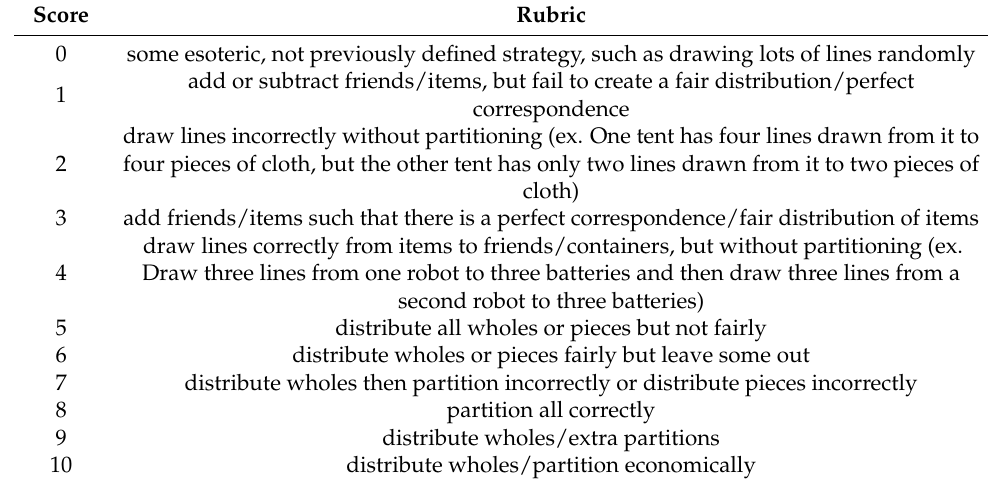
Table 3. Math Stories Scoring Rubric.